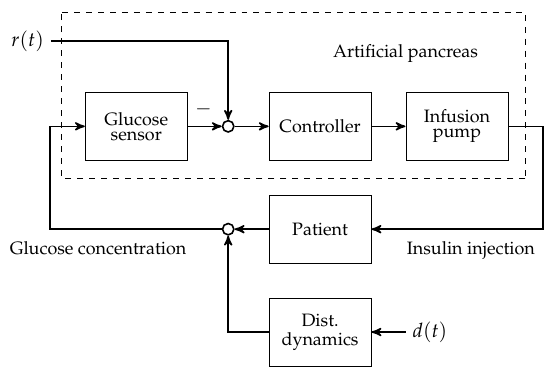
Figure 1. Overview of the artificial pancreas components with reference r ( t ) and disturbance d ( t )